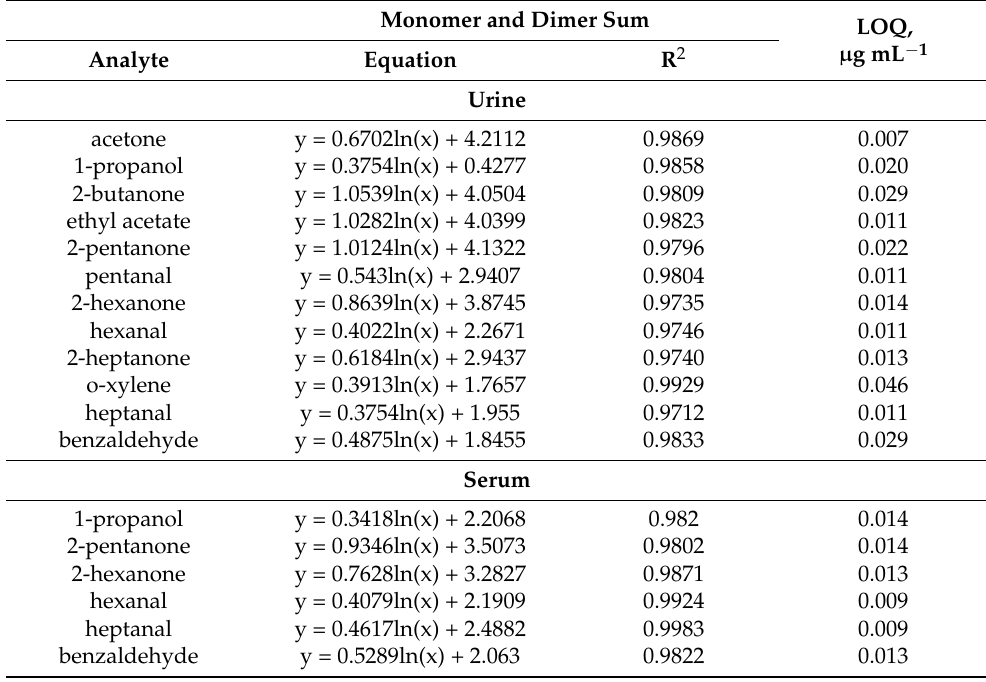
Table 3. Analytical performance characteristics and calibration curves of the HS-GC-IMS method when using logarithmic regression for urine and serum samples.